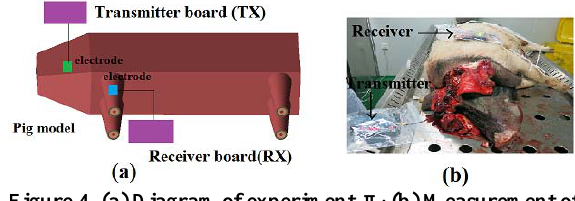
Figure 4. (a) Diagram of experiment Ⅱ ; (b) Measurement of different electrode size via transmitter and